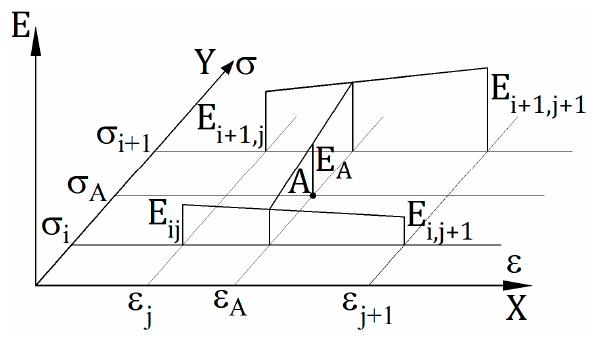
Figure 3. Determining the modulus value at point A .